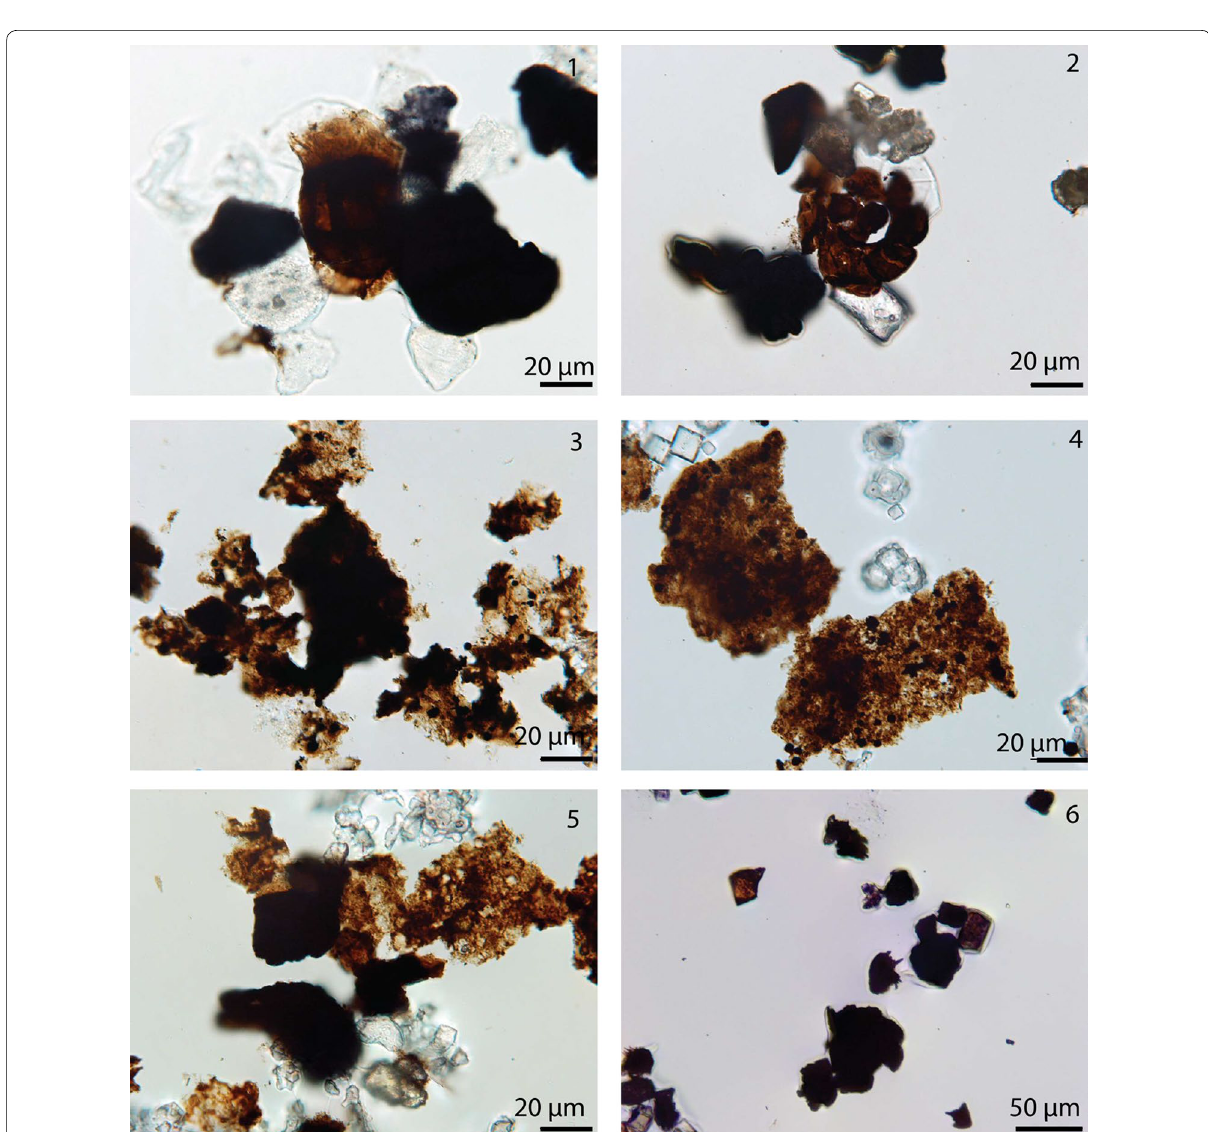
Fig. 4 Different particulate organic matter compositions in the Georgetown core succession: 1 Kerogen GTB 001 K a 12.2/123.3; 2 Kerogen GTB 004 K a 10.5/126.3; 3 Kerogen GTB 020 K a 20.7/128.3; 4 Kerogen GTB 036 K a 6.7/135.1; 5 Kerogen GTB 048 K a 9.4/141.5; 6 Kerogen GTB 052 K a